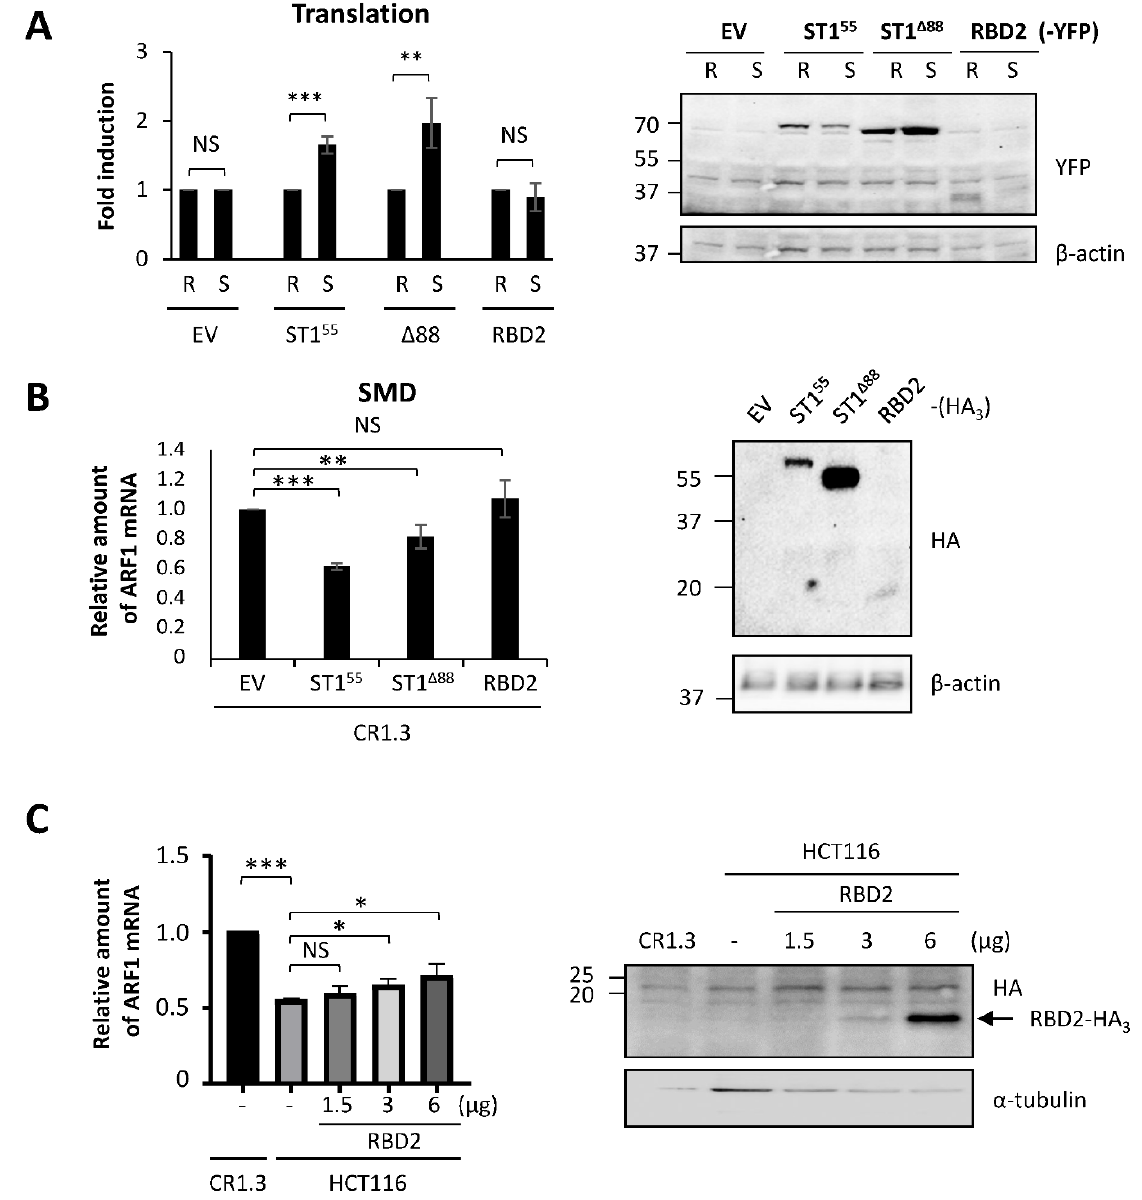
Figure 6. RBD2 expression impairs SMD via interference with endogenous STAU1 55 functions. ( A ) HEK293T cells were co-transfected with plasmids coding for the reporter Rluc or SBS-Rluc pro- teins and for RBD2-YFP or controls (ST1 55 , Δ88) as indicated. (Left panel) Relative translation of Rluc (R) and SBS-Rluc (S) is shown. The graph represents the means and standard deviations of three independently performed experiments. **, p - value ≤ 0.01; ***, p - value ≤ 0.001. NS, not significant . Translation of Rluc in the presence of the empty vector (EV) was arbitrary fixed to 1. (Right panel) Cell extracts were collected 24 h post-transfection, and the expression of STAU1 55 proteins was an- alyzed by western blotting. ( B ) STAU1-KO HCT116 (CR1.3) cells were transfected with plasmids coding for RBD2-HA 3 or controls (EV, ST1 55 , Δ88) as indicated. (Left panel) RNAs were isolated, and ARF mRNA was quantified by RT-qPCR using HPRT and RPL22 mRNAs as normalization controls. The graph represents the means and standard deviations of three independently performed exper- iments. **, p - value ≤ 0.01; ***, p - value ≤ 0.001. The expression of ARF mRNA in CR1.3 cells trans- fected with empty vector (EV) was arbitrary fixed to 1. (Right panel) The expression of the proteins was analyzed by western blotting. ( C ) HCT116 cells were transfected with increasing concentrations of plasmids coding for RBD2-HA 3 as indicated. (Left panel) RNAs were isolated, and ARF mRNA was quantified as above. *, p - value ≤ 0.05. The expression of ARF mRNA in untransfected STAU1-